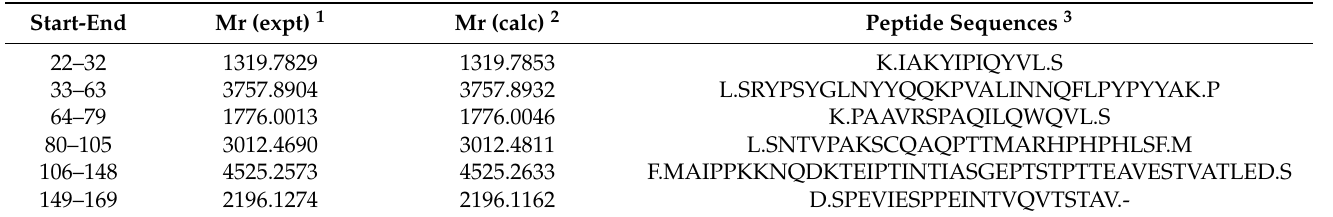
Figure 4. SDS-PAGE analysis of α s -casein ( A ), β -casein ( B ), and κ -casein ( C ) hydrolyzed by RmproB. Lane M, protein molecular weight marker; other lanes, three types of caseins hydrolyzed by RmproB (10 SU/mL) in 50 mM pH 4.0 citrate buffer for 0, 5, 10, and 30 min. Table 2. Identity of Peptides Derived from K-Casein Hydrolyzed by